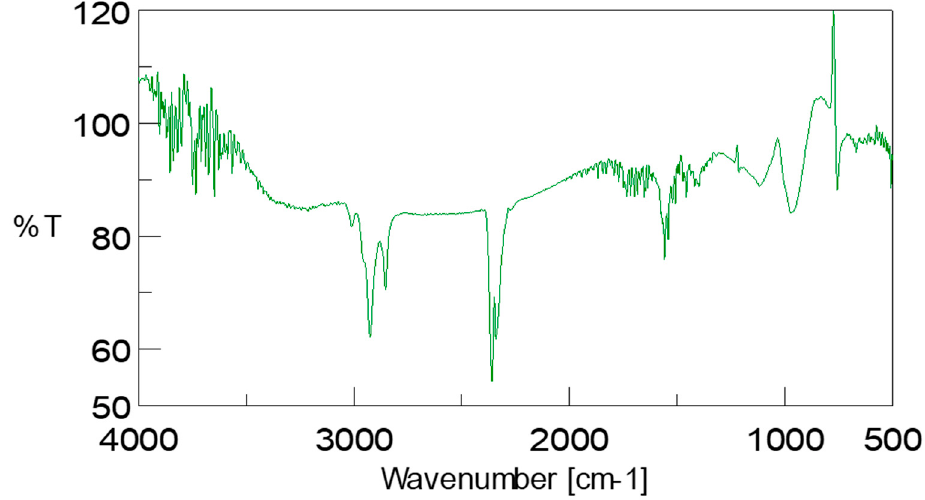
Figure 6. FT-IR spectrum of Scenedesmus rotundus -MG910488 biodiesel. Based on the IR results reported, the peak at 2855–3000 cm − 1 indicates the methylene and methyl stretching, which shows lipid content. The peak of FTIR at 3011.30 cm − 1 shows the (-CH=CH-) vibrational band from the unsaturated fatty acid and the peak at 1733.60 cm − 1 shows the presence of carbonyl (C=O) group of triglycerides, and the (O-H) stretching band indicate the hydroxyl group at 3211.85 cm − 1 . C-H stretching band is confirmed by 2854.18 cm − 1 2925.48 cm − 1 and 3011.30 cm − 1 . Peaks at 1715 ± 100 cm − 1 , as reported in the